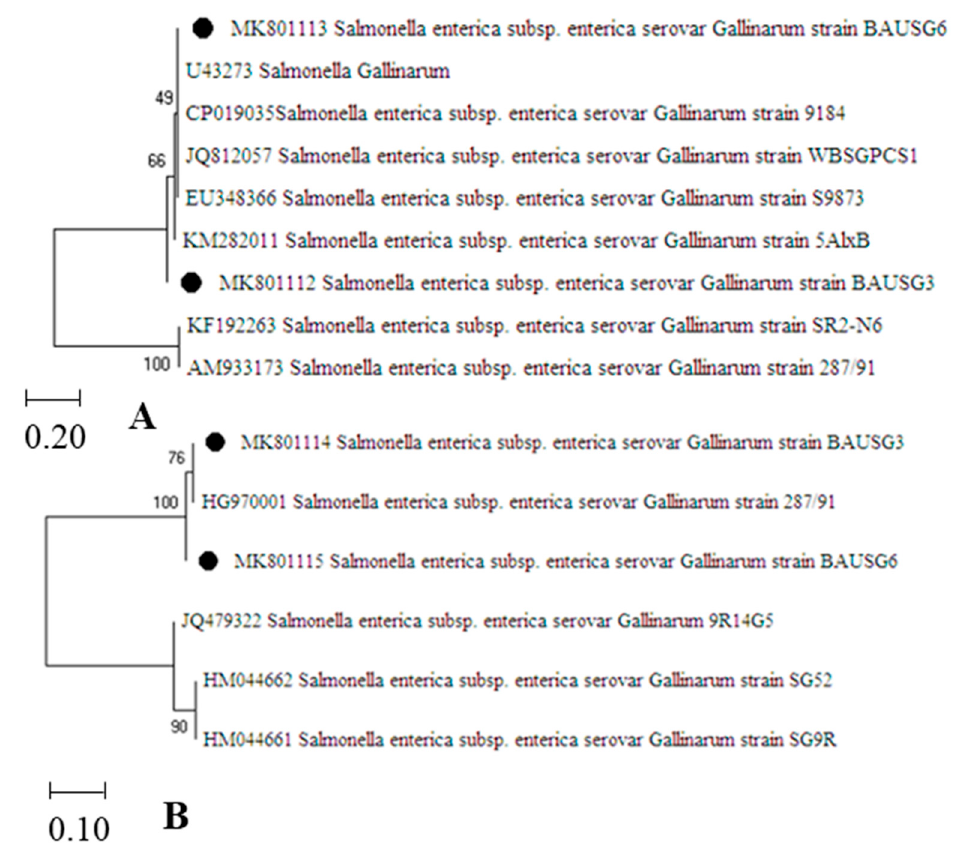
Figure 3. Phylogenetic analysis of ( A ) invasive gene ( inv A) and ( B ) plasmid virulence gene ( spv C) of Salmonella Gallinarum strains (BAUSG3 and BAUSG6). The phylogenetic tree was constructed using the Neighbour-Joining (NJ) method with comparative alignment of 266 nucleotides of invA ; and 572 nucleotides of spvC . BAUSG3 and BAUSG6 are marked as black circles in the phylogenetic tree, comparing their affinity to selected sequences of the target genes downloaded from the